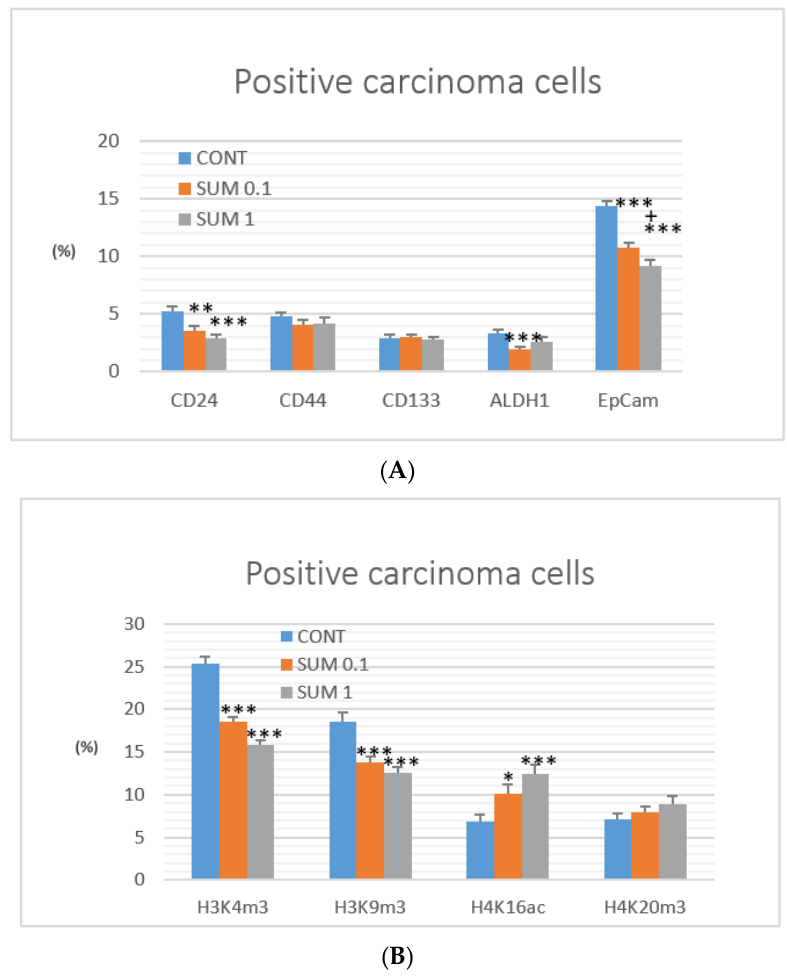
Figure 5. Immunoexpression of cancer stem cells ( A ) and epigenome ( B ) markers in rat mammary carcinoma cells after treatment with R. coriaria . Data are expressed as mean ± SEM. Significant difference: * p < 0.05, ** p < 0.01, *** p < 0.001 vs. CONT, + p < 0.05 vs. SUM 0.1. The values of protein expression were compared between treated (SUM 0.1, SUM 1) and non-treated (control) carcinoma cells of female rats; at least 60 images for one marker were